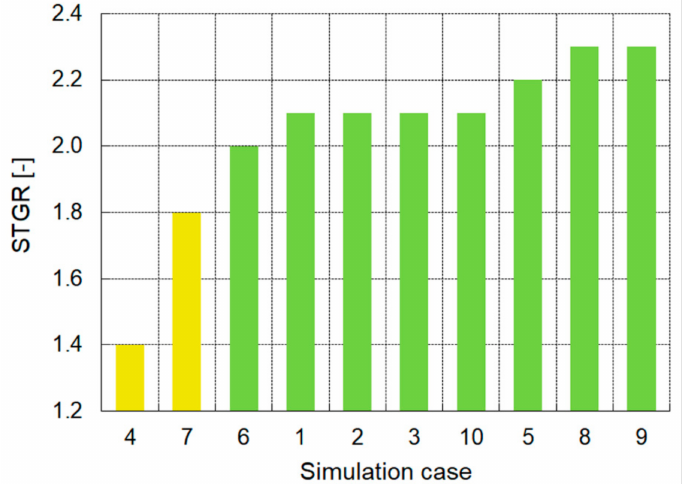
Figure 8. Comparison of the soil temperature gradient ratios (STGRs) for the considered simula- tion